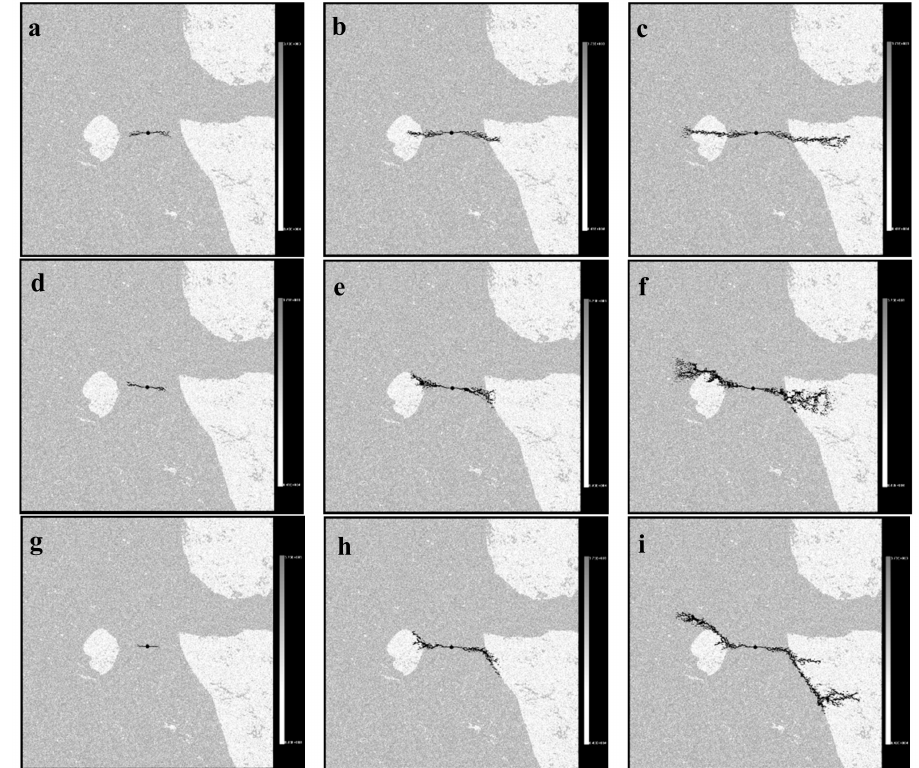
Figure 11. Numerically obtained fracturing process in Case A, B and C. ( a – c ) correspond to those in Case A, ( d – f ) in Case B, and ( g – i ) in Case